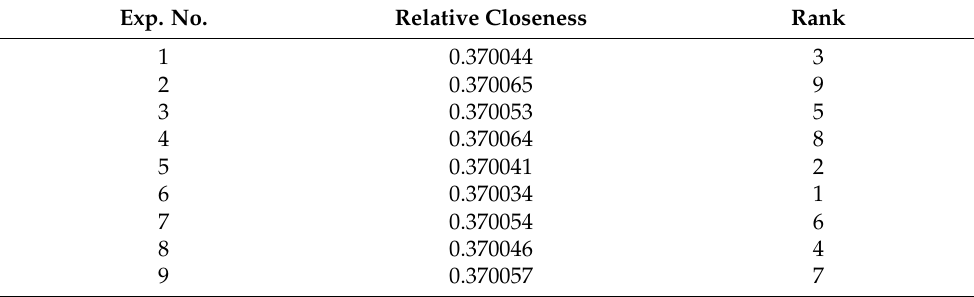
Table 8. Relative